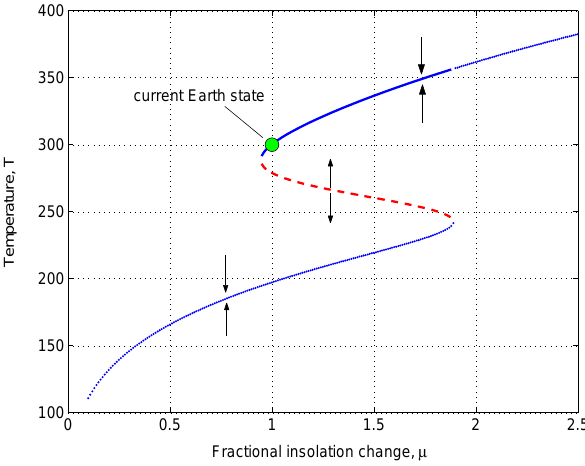
Fig. 4. Outgoing radiation R o (red, dashed line) and absorbed in- coming solar radiation R i (blue, solid lines) for our 0-D energy- balance model (EBM), governed by Eq. (15). The absorbed radi- ation is shown for µ = 0 . 5 , 1 and 2.0 (from bottom to top), while κ = 0 . 05. Notice the existence of one or three intersection points between the R o curve and one of the R i curves, depending on the value of µ ; these points correspond to the equilibrium solutions of Eq. (15), i.e. to steady-state climates.